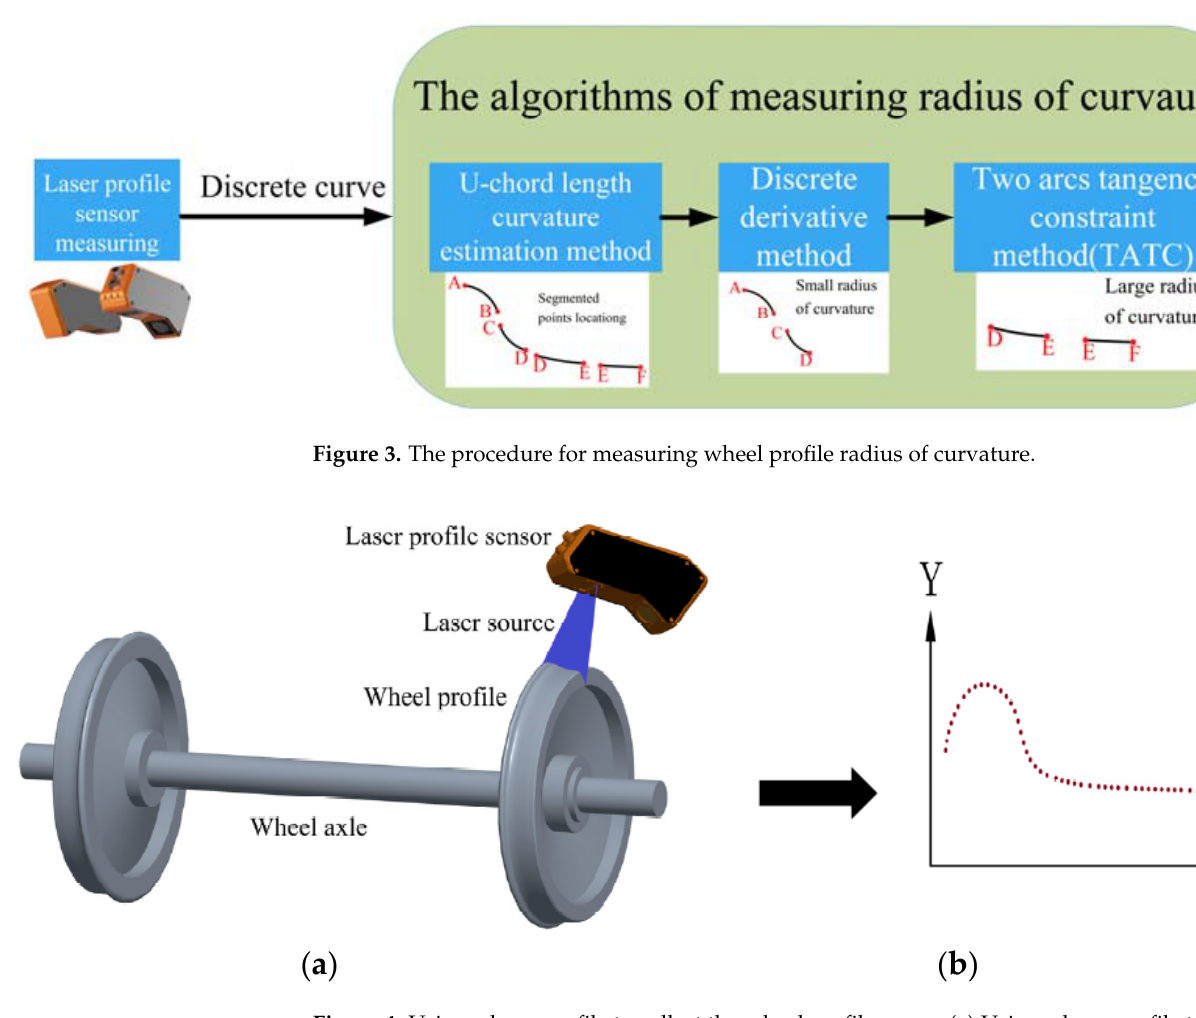
Figure 4. Using a laser profile to collect the wheel profile curve. ( a ) Using a laser profile to measure the wheel profile. ( b ) Collecting the wheel profile as a discrete curve.